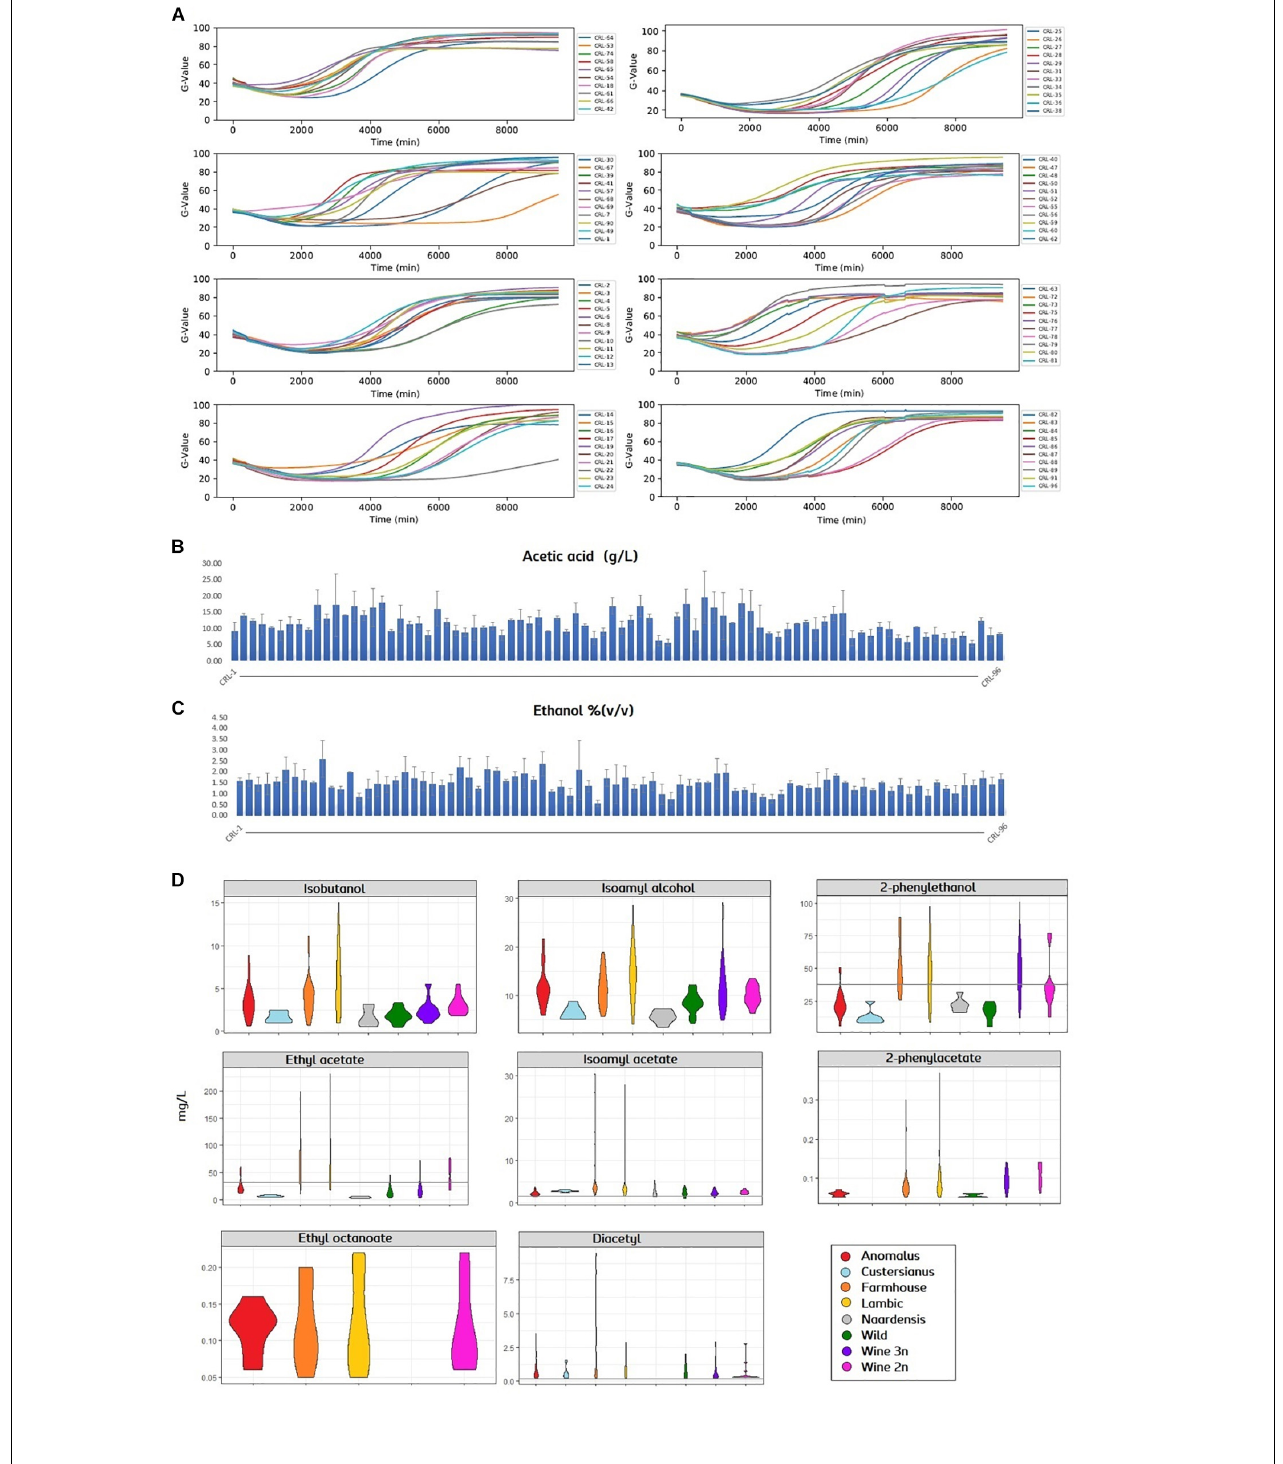
FIGURE 5 | (A) Growth curves of Brettanomyces strain collection in pilsner wort, shown by means ( n = 3). Growth-related values (G-value, y -axis) were extracted with the image analysis software (Enzyscreen). Fermentation time is indicated in minutes ( x -axis). (B,C) Acetic acid and ethanol content of beers produced. Error bars show standard deviation ( n = 3). (D) Violin plot for the main volatiles measured in beers. Strains are grouped according to its genetic cluster. Sensory detection threshold is indicated by a continuous line. When the line is not present, measured values are below detection threshold. Plots were obtained using ggplot2 package in R. Quantified values and statistical test can be found in Supplementary Table S2 and Statistical Test 1, respectively.